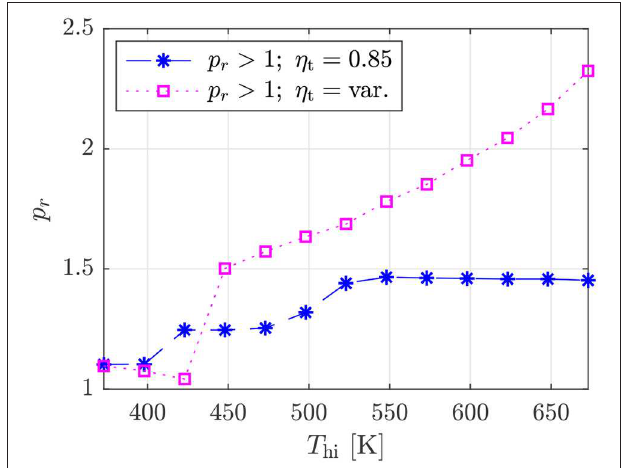
FIGURE 8 | Turbine performance for the optimal subcritical ( p r < 1) and transcritical ( p r > 1) cycles for different heat-source temperatures obtained using the variable efficiency model: (A) turbine efficiency; and (b) expansion parameters.